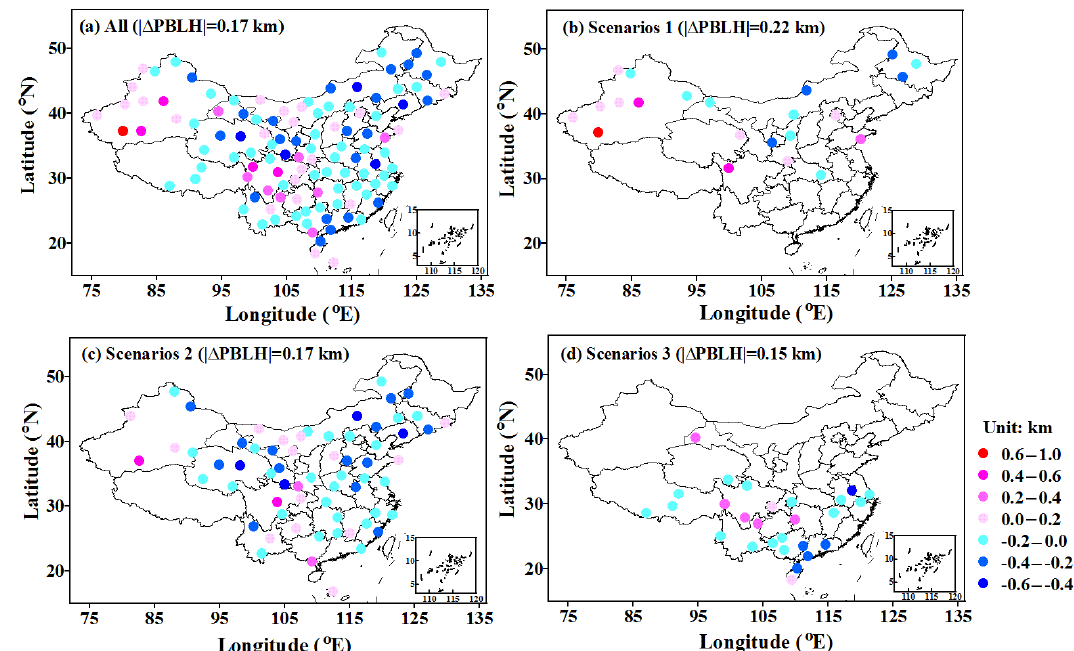
Figure 7. The geographic distribution map concerning the absolute difference of PBLH derived from CALIOP at 13:30LT minus that derived from radiosonde observations at 14:00BJT in the summertime (June–July–August) during the period of 2011–2014. The differences of PBLHs are shown for all radiosonde sites in China (a) and for the radiosonde sites belonging to scenario 1 (b) , scenario 2 (c) , and scenario 3 (d) .